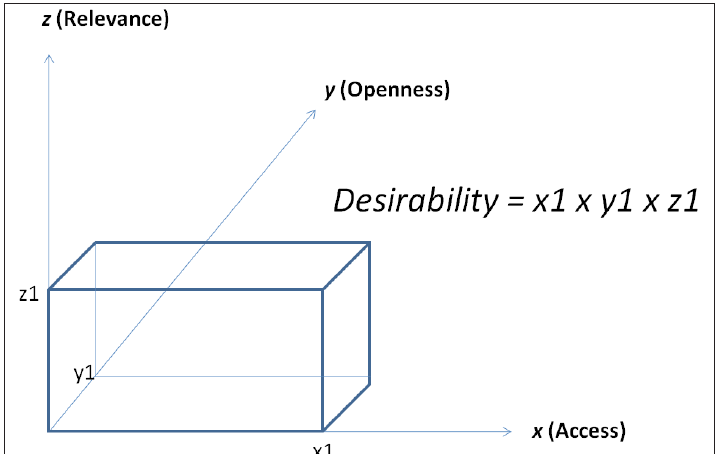
Figure 2 . Calculation of